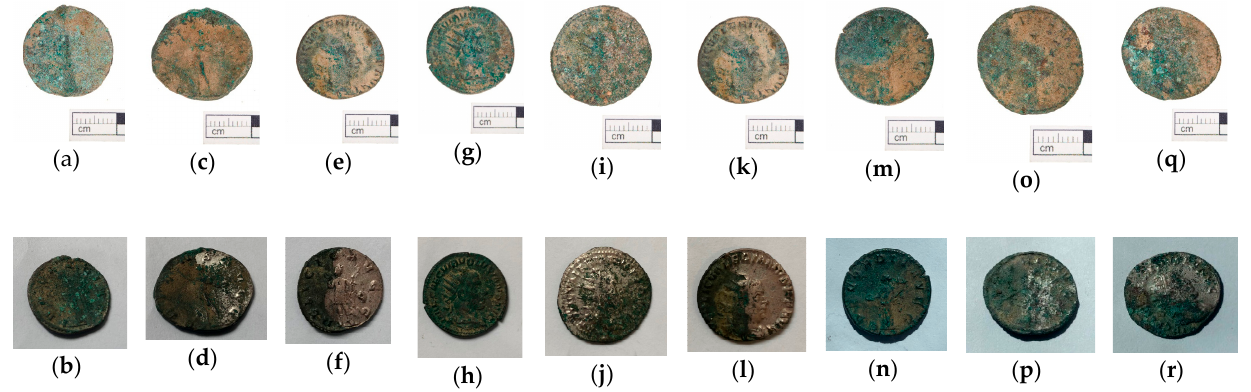
Figure 3. Coins from the Cléons treasure (only half of the coin’s surface was treated in each case) before or after treatments: before ( a ) and after 5 applications of agar with di-EDTA 0.5 wt% ( b ),